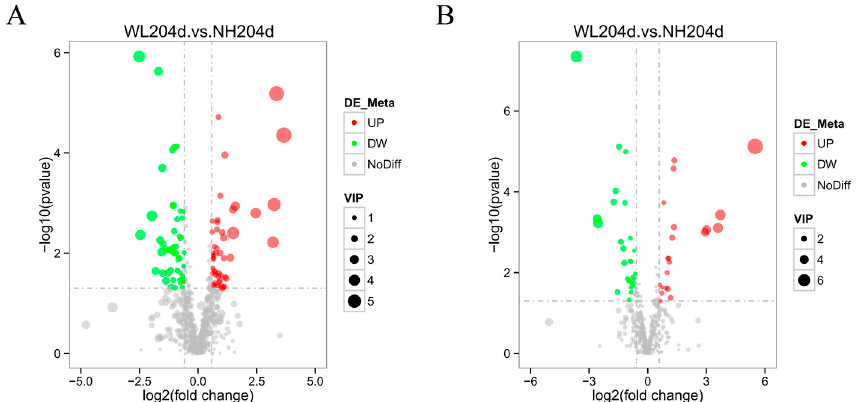
Figure 3. Volcano plots of differential metabolites in the ovaries of hens with different egg production rates. Red represents significantly up-regulated differential metabolites, green indicates significantly down-regulated differential metabolites. ( A ) Differential metabolites in the negative model; ( B ) Differential metabolites in the positive model.